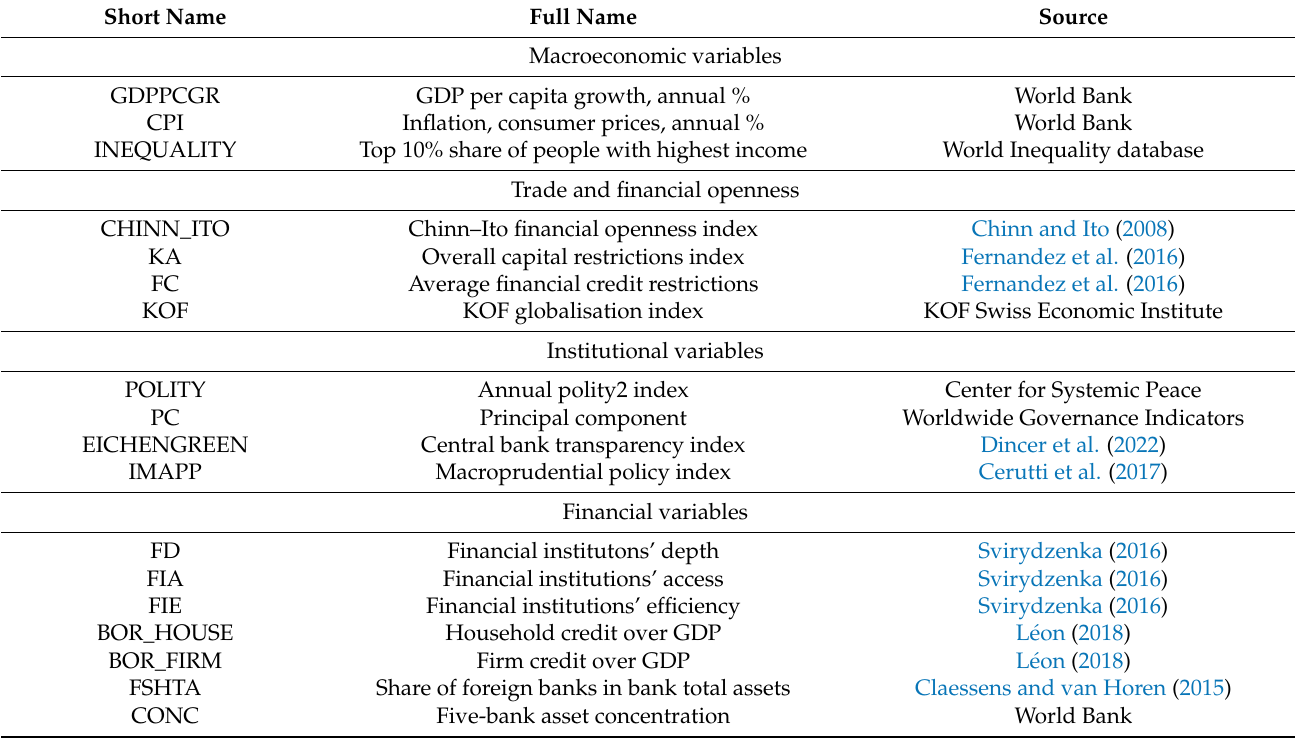
Table 5. Predictors for Bayesian logit model.